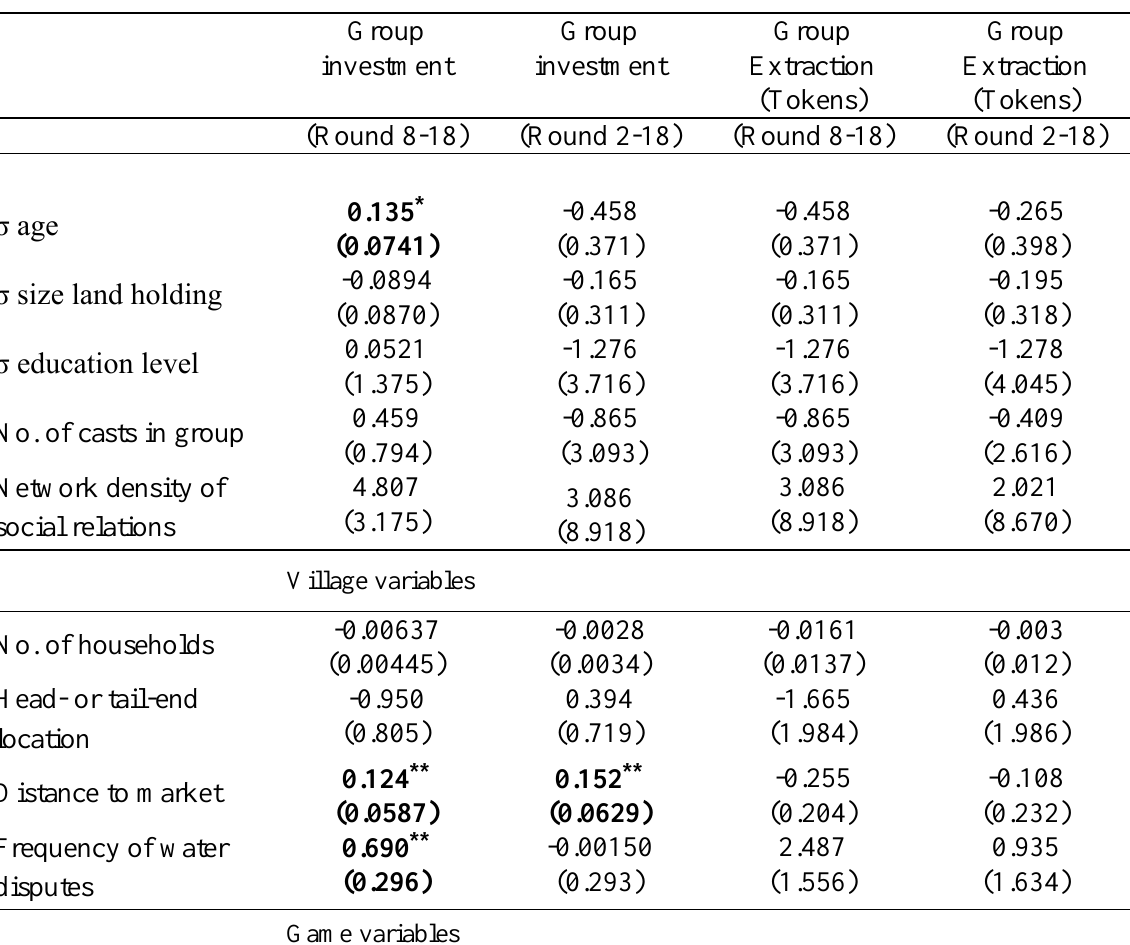
Table A4.4. Mixed effects regression models explaining the total tokens invested and earned from water extraction by groups (coefficients with robust standard errors in parentheses; * p < 0.1, ** p < 0.05, *** p <